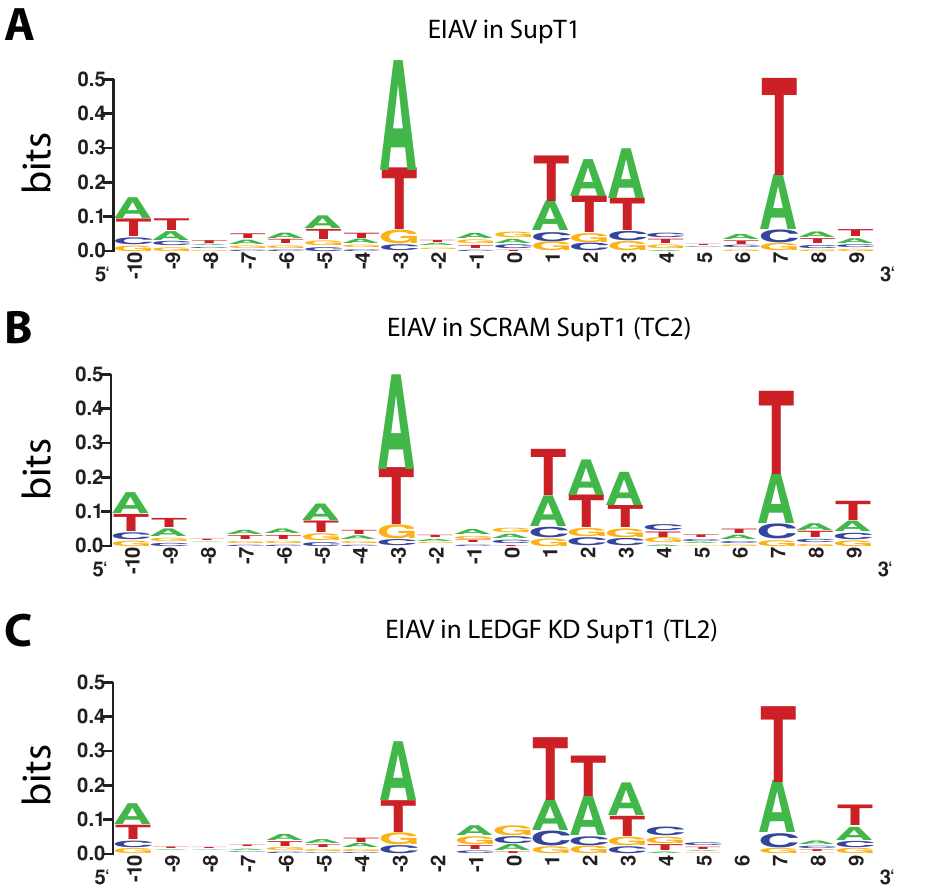
Figure 3. Integration site consensus at sequences flanking EIAV proviruses in control and LEDGF/p75-knockdown SupT1 cells. A) Unmodified SupT1 cells. B) Control SCRAM cells. C) LEDGF KD cells. The diagrams were generated using the WebLOGO program (weblogo.berkeley.edu/logo.cgi). The y-axis indicates bits of information–perfect conservation of a base would score as two bits.